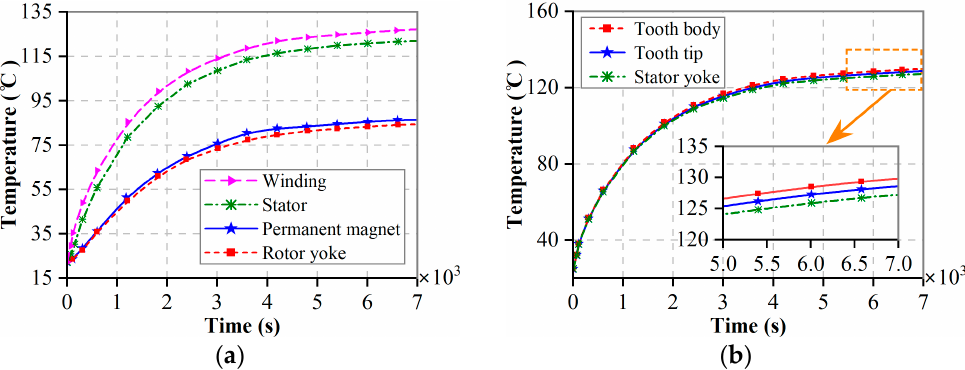
Figure 10. Temperature rise curve of PM-IWM components under on-load condition. ( a ) Motor components; ( b ) Stator components. components; ( b ) Stator